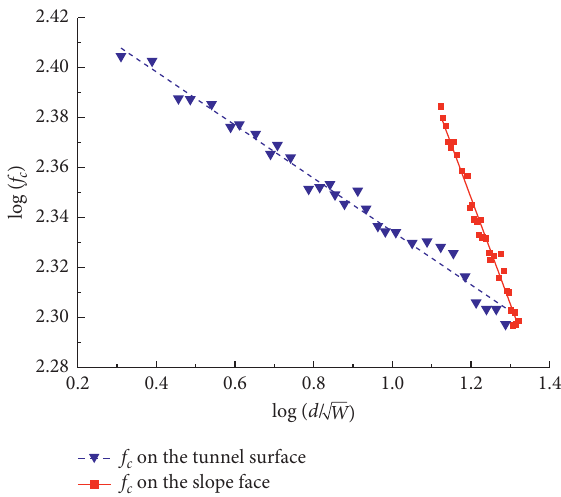
Figure 17: Center frequency versus scaled distance based on the numerical